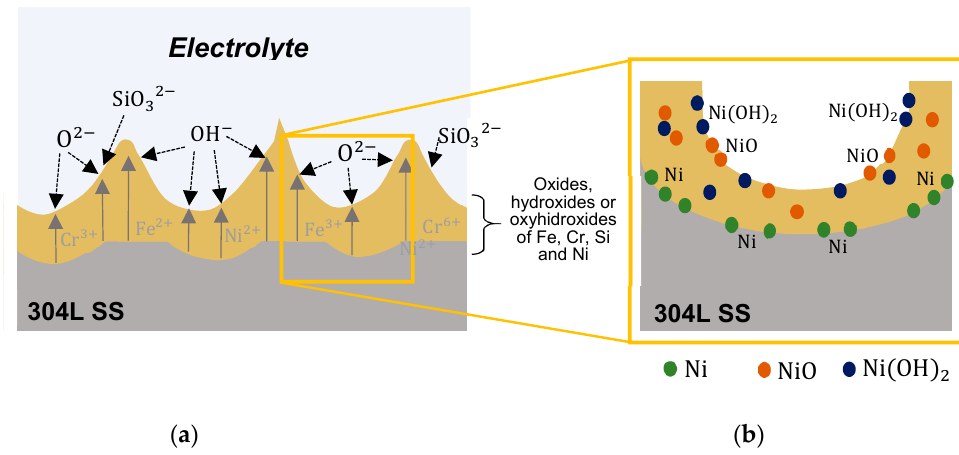
Figure 12. ( a ) Schematic illustration of the mechanism during the anodizing process. ( b ) Distribution of Ni in the anodic layer.